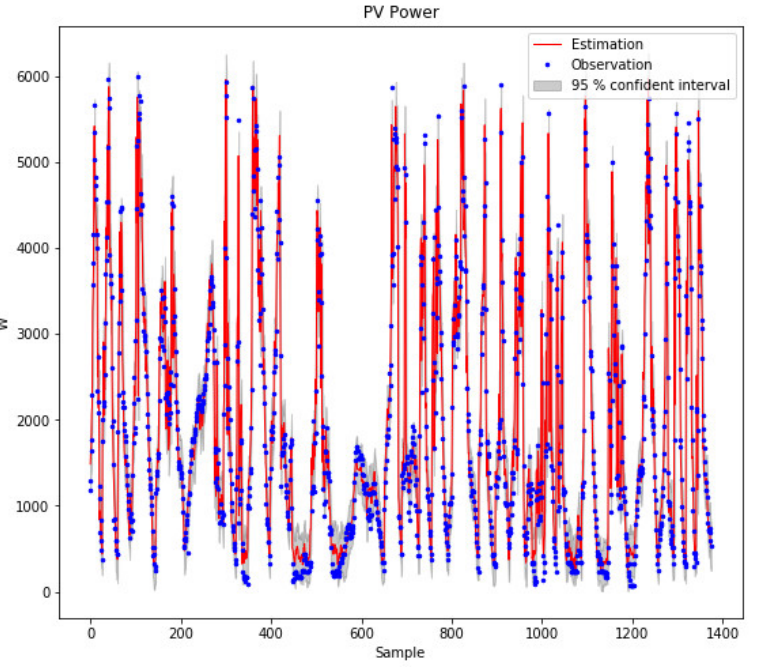
Figure 11. Data compensation of PV power. Table 7. Performance indices of the compensation of PV power